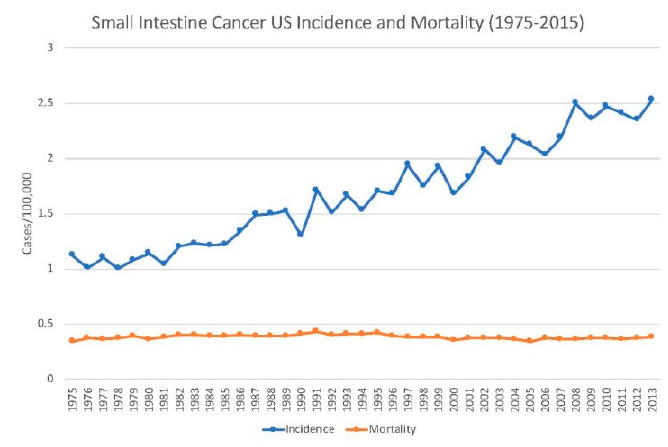
Figure 2. Incidence and mortality rates of small intestine cancer in the United States from 1975 to 2015 (data obtained from the Surveillance, Epidemiology, and End Results (SEER) database) .